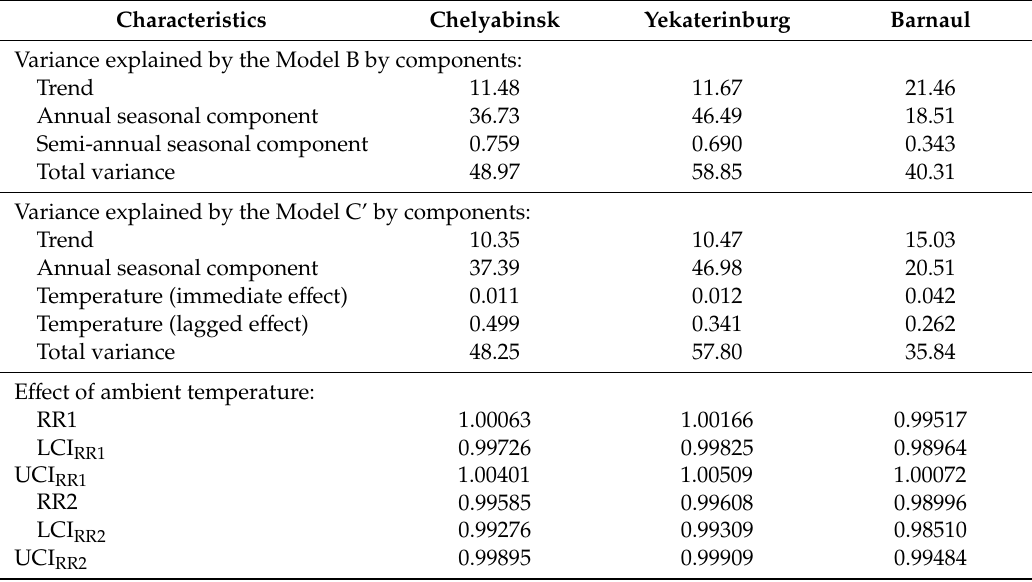
Table 4. Variance explained by the Model B and C’ components and the immediate and lagged e ff ects of ambient temperature estimated from Model C’ in three